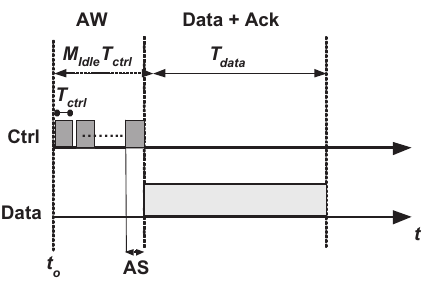
Figure 4. AW-MAC basic